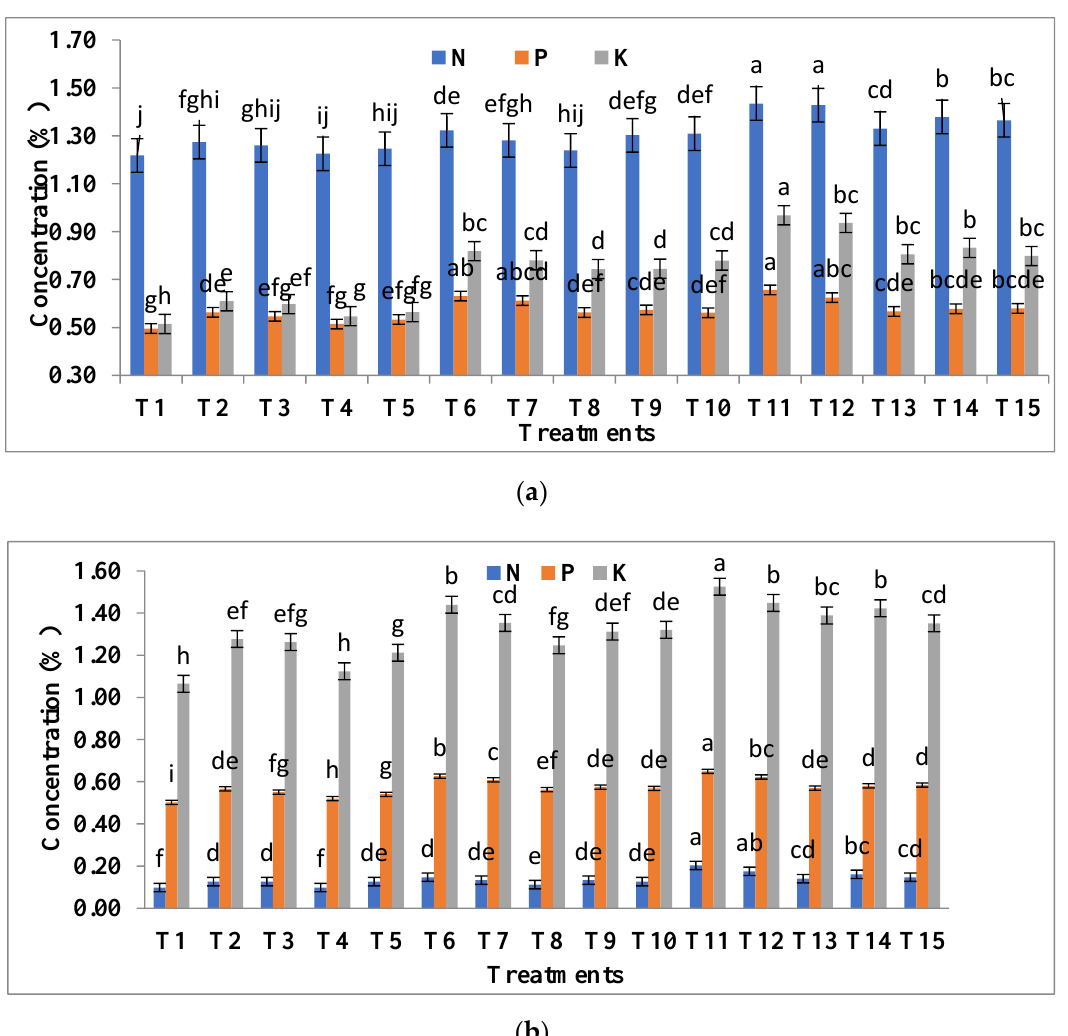
Figure 2. Effect of different fertilizers and manures on macronutrient concentration (N, P and K) in ( a ) grain and ( b ) straw of wheat. Treatment details are given in Table 1. The bar with similar or dissimilar letter(s) was evaluated with the least significant difference (LSD) multiple range tests using a probability level of p ≤ 0.05.